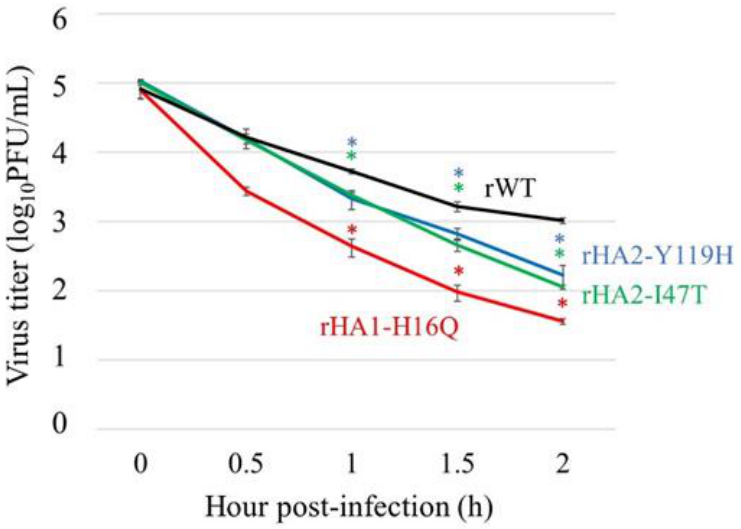
Figure 6. Thermostability of HA mutant viruses. Aliquots containing 1 × 10 5 PFU/mL of the recombinant viruses possessing mutations (rHA1-H16Q, rHA2-I47T, or rHA2-Y119H) or rWT were heated at 50 °C for 0, 30, 60, 90, and 120 min, and immediately placed on ice. Virus titer was measured using plaque assay in MDCK cells. Each data point is the mean ± SD of triplicated experiments. * p < 0.05, compared with that of rWT using Dunnett’s test.